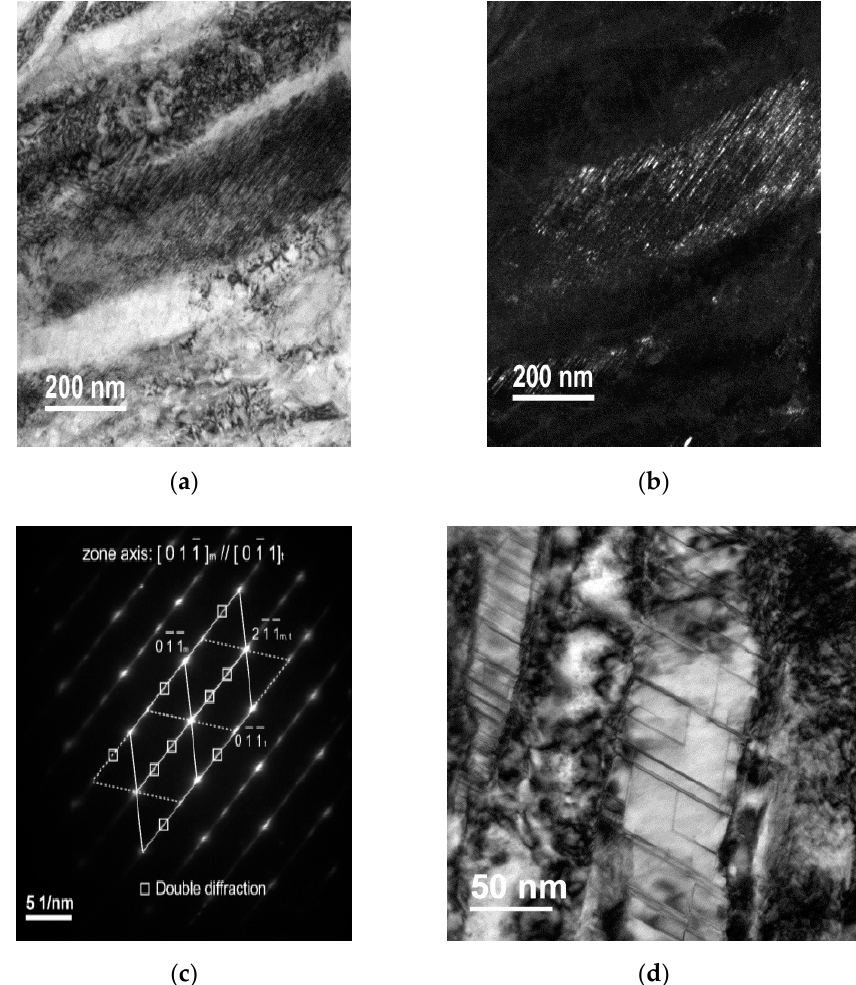
Figure 4. ( a ) Bright and ( b ) dark field TEM images, and ( c ) corresponding diffraction pattern, of twinned martensite in bainite formed at 220 °C for 22 h and deformed up to 2% strain in a high-carbon (1.0 wt.%) and high-silicon (2.5 wt.%) steel. ( d ) Bright field micrograph of mechanical twins in austenite in the same bainitic structure deformed up to 6% strain.